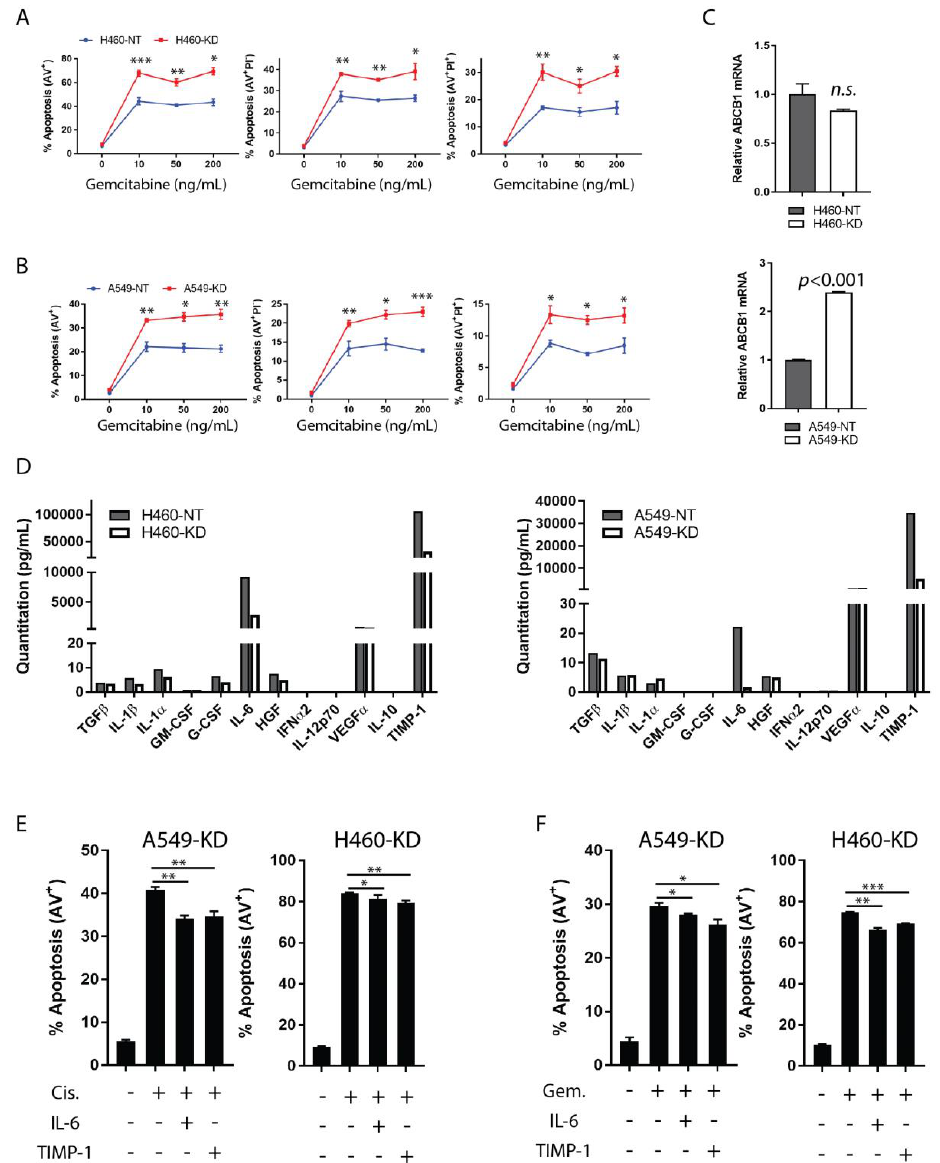
Figure 1. IL-6 is a determinant in TIMP-1-mediated chemoresistance. ( A , B ) Human NSCLC cells (A549 and H460) encoding non-target scrambled shRNA (NT) sequence, or TIMP-1-specific knockdown shRNA (KD) sequence were seeded in 24-well plates (3 × 10 4 / well). At log-phase, cells were treated with variable doses of Gemcitabine as indicated. All floating and adherent cells were collected at 72 h post-treatment, stained with Annexin V and PI and analyzed by flow cytometry. Statistical analysis of total apoptosis (Annexin V + ), early apoptosis (Annexin V + PI − ), and apoptotic cell death (Annexin V + PI + ) is shown for H460-derived cells ( A ) and A549-derived cells ( B ). ( C ) Total RNA was extracted from NT and KD clones of A549 and H460. Real-time quantitative RT-PCR was performed to measure the mRNA transcripts of the ABCB1 gene. ( D ) H460- (left panel) or A549- (right panel) NT and KD clones suspended in complete fresh medium were cultured for three days. Supernatants collected at 72 h were titrated for absolute concentrations of the following: TGF-ß, IL-1ß, IL-1a, GM-CSF, G-CSF, IL-6, HGF, IFN α 2, IL-12p70, VEGF-A, IL-10, and TIMP-1, with a multiplex human custom panel by Bead-based cytokine immunoassay (BCA). ( E , F ) A549- or H460-derived TIMP-1 KD clones were cultured in complete medium without, or supplemented with exogenous rhIL-6 (25 ng / mL) or rhTIMP-1 (25 ng / mL) in the presence or absence of chemotherapeutic agents (25 µ g / mL Cisplatin or 10 ng / mL Gemcitabine), respectively, for 72 h. Apoptosis was analyzed by Annexin V and PI staining, followed by flow cytometry. Statistical significance is denoted as follows: * p < 0.05; ** p < 0.01; *** p <